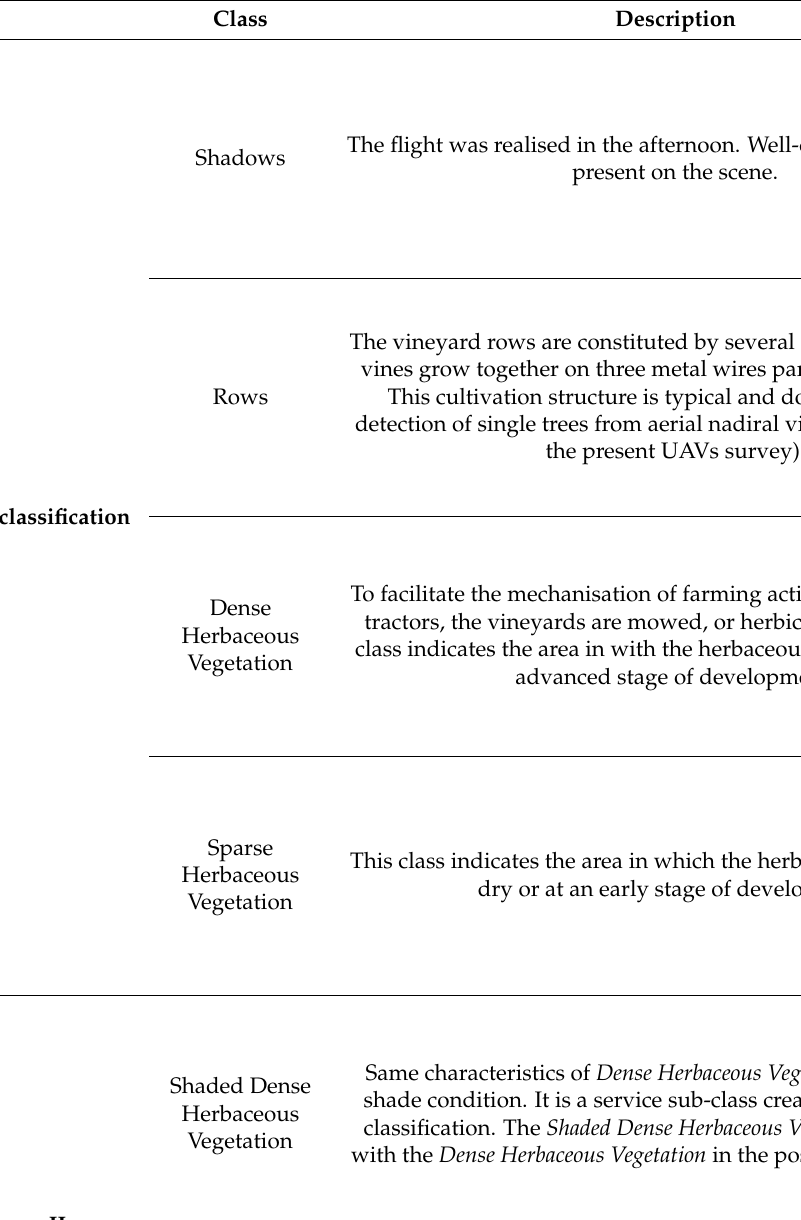
Table 2. Qualitative description of the classes according to first level classification (Classification I) and second-level classification (Classification II).